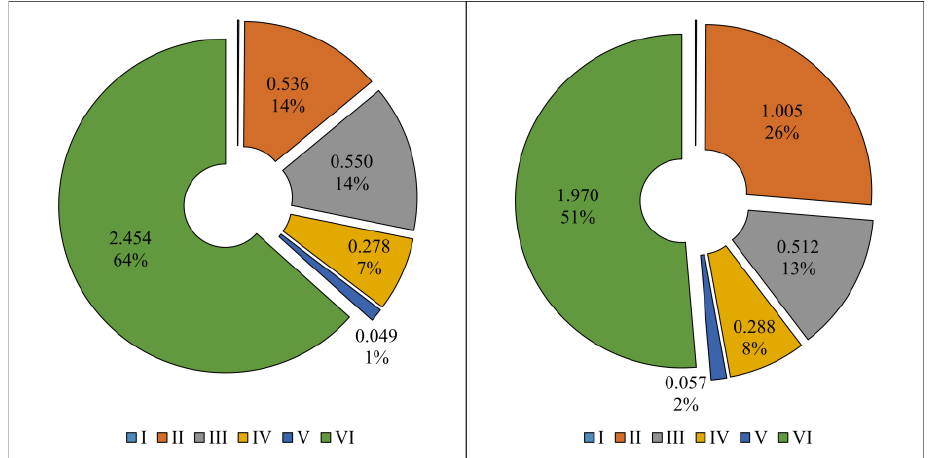
Figure 9. Shares of different U fractions in the sediments of Lake Chetyrekhverstnoe (I—water-soluble fraction, II—exchangeable forms, III—hydrated Fe and Mn oxides, IV—organic matter, V—acid-soluble (residual) fraction, VI—mineral (stable) fraction).